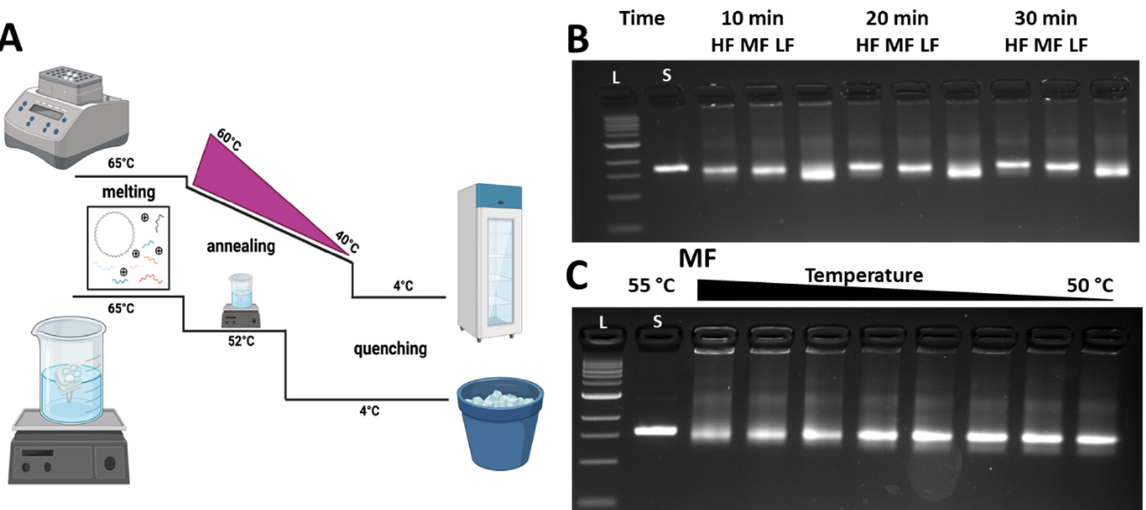
Figure 3. Protocol optimization for class. ( A ) Schematic of annealing ramp during folding process between laboratory and class. ( B ) Folding time optimization and temperature sensitivity test. ( C ) Temperature tested in 55, 54.7, 54.2, 53.2, 52, 51, 50.3, 50 °C for structure annealing.